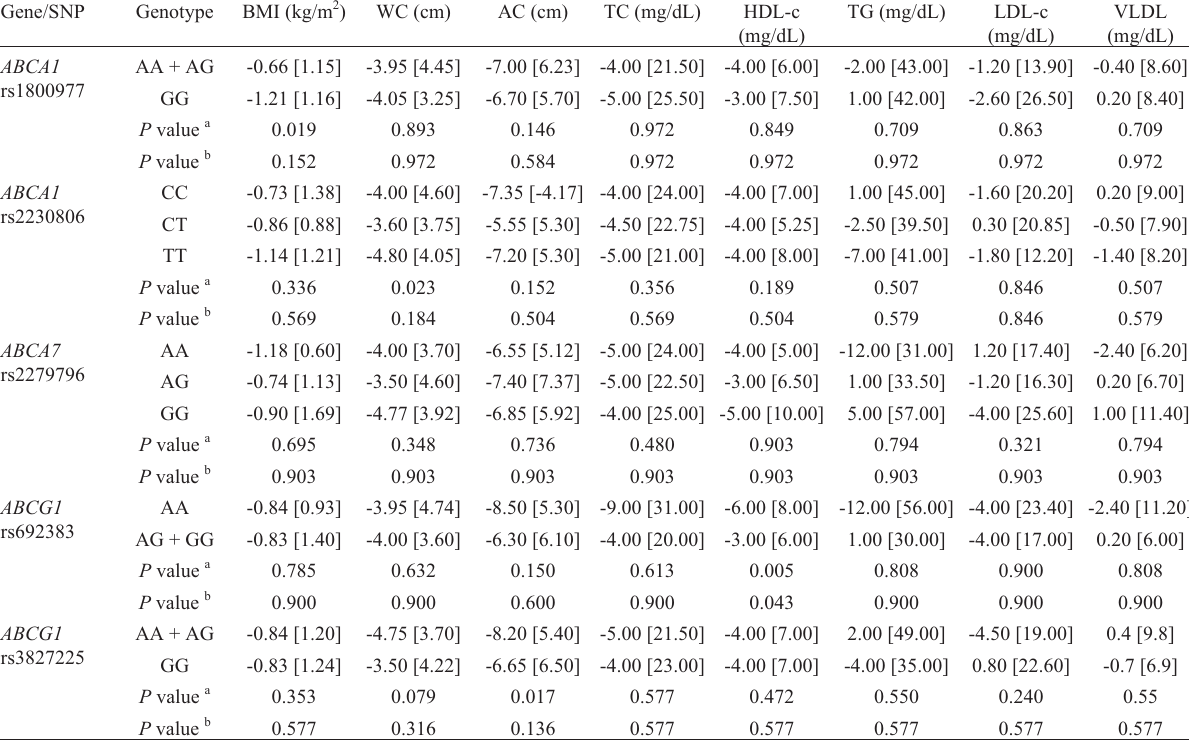
Table 5 - Characteristics changes after dietary intervention relative to baseline measures (median [IQR]) according to the ABCA1 , ABCA7 and ABCG1